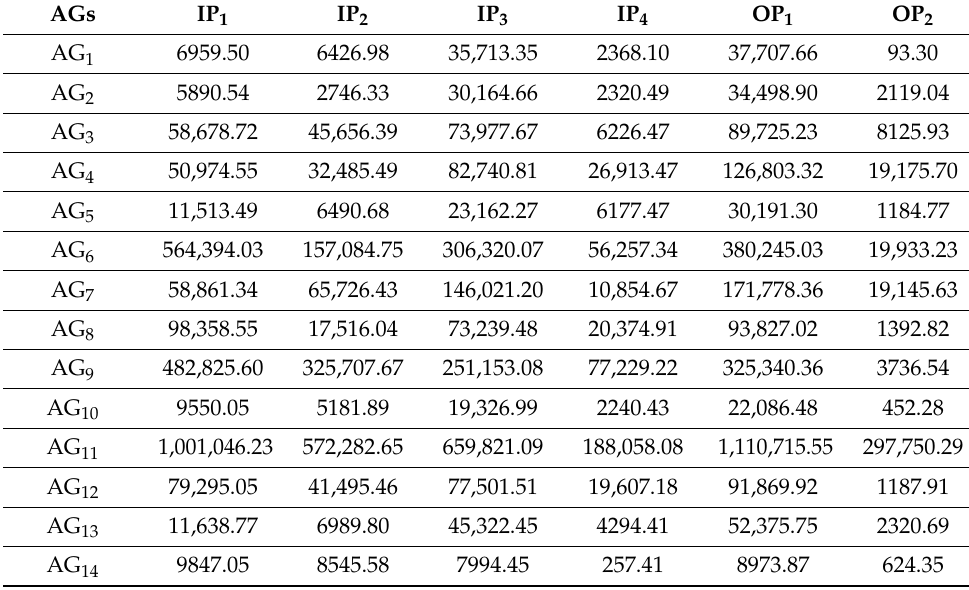
Table 10. Data in 2021 (Unit: 1000